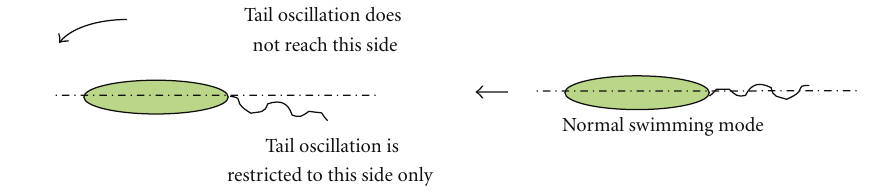
Figure 29: Dynamic turning while swimming.